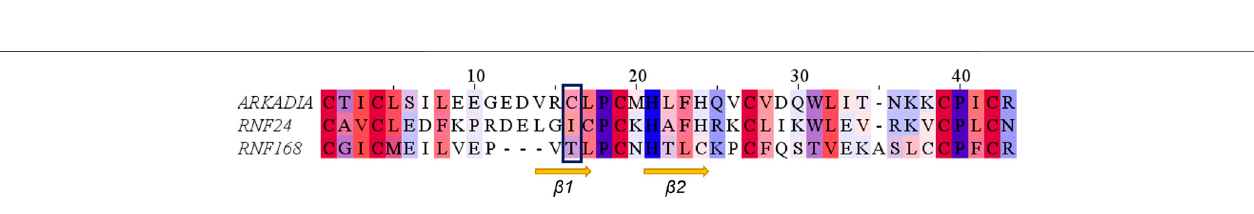
FIGURE 12 | Alignment of the RING domains of R957C Arkadia, RNF24 and RNF168 E3 ubiquitin ligases. Coloring by residue hydrophobicity and sequence conservation.